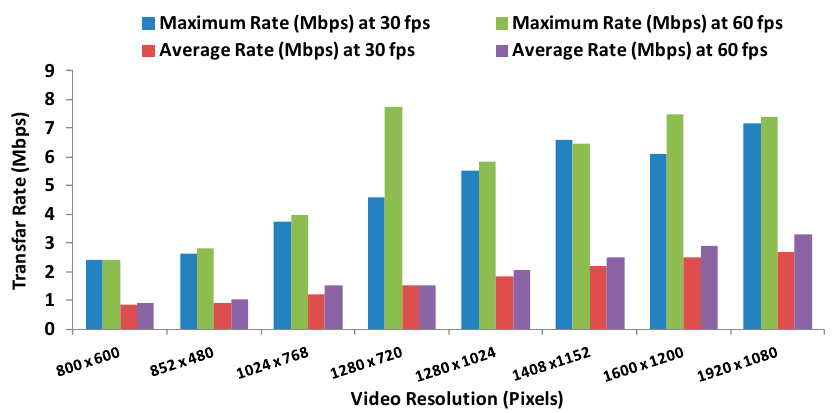
Figure 5. Maximum and average data transfer rate for each video at 30 fps and 60 fps.